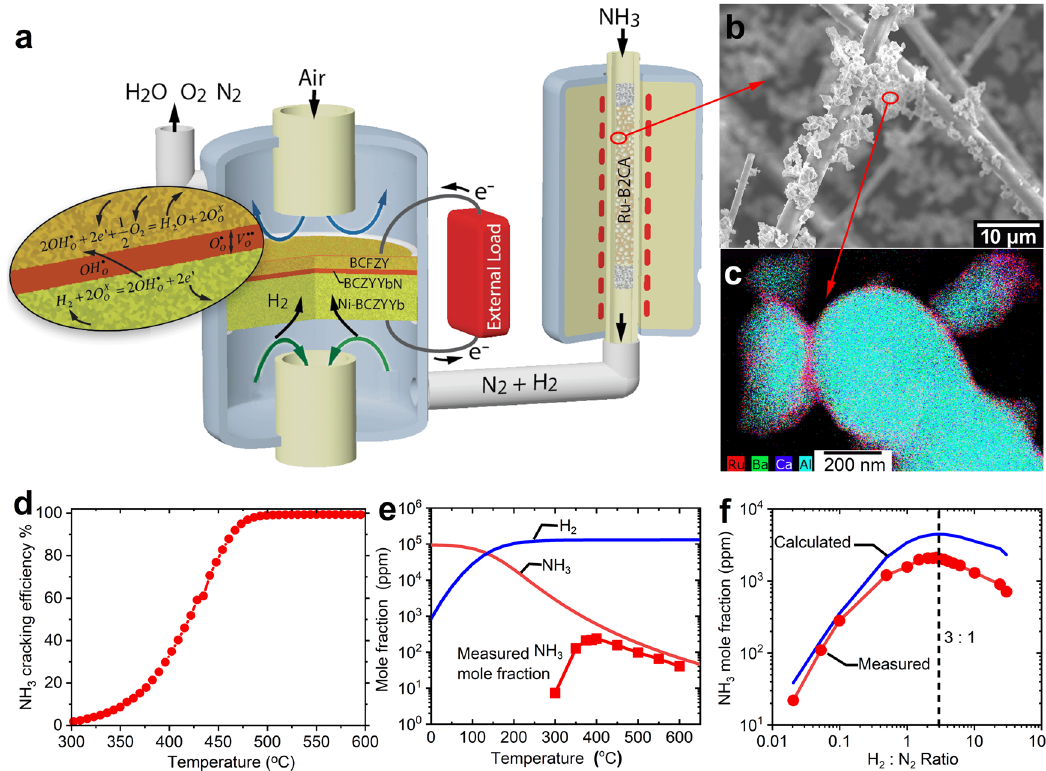
Fig. 1 Design of decoupled ammonia power generation and production approach and characterization of the Ru-B2CA catalyst and support. a Schematic process fl ow for ammonia power generation. The process is reversible for ammonia production. b Ru-B2CA is mixed with refractory insulation fi bers in order to facilitate mass transport and minimize pressure change in the ammonia synthesis/cracking reactor when coupling to a ceramic cell. c TEM-EDX elemental maps showing reasonable uniformity across 300-nm particles and evidence of Ru-B2CA core-shell structure. d Measured cracking ef fi ciency of Ru-B2CA as a function of temperature. Testing conditions: 0.2 g of 1 wt. % Ru-B2CA mixed with 0.4 g of Al 2 O 3 , 10 sccm NH 3 , 1 atm pressure. e Measured ammonia production rate as a function of temperature with comparison to thermodynamic calculations. Testing conditions: 8 g of 2.5 wt. % Ru-B2CA mixed with 8 g of thermal insulation fi bers, 100 sccm N 2 and 15 sccm H 2 , 1 atm pressure. f Measured ammonia production rate as a function of H 2 to N 2 ratio with comparison to thermodynamic calculations. Testing conditions: 2.5 g of 5 wt. % Ru-B2CA mixed with 2.5 g of thermal insulation fi bers, 100 sccm total fl ow rate, 1 atm pressure, reactor temperature at 400